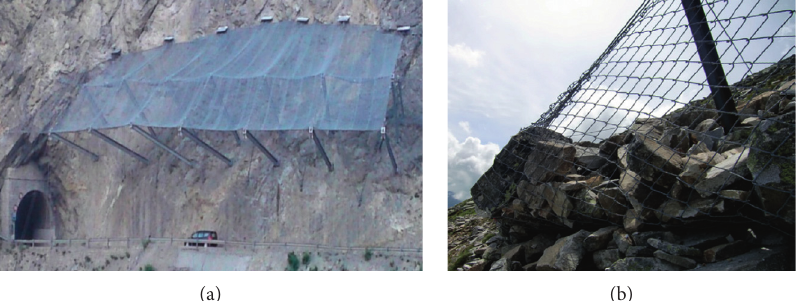
Figure 1: Application example of the metal flexible net in flexible protection system. (a) Cantilever flexible protection system. (b) Passive flexible protection